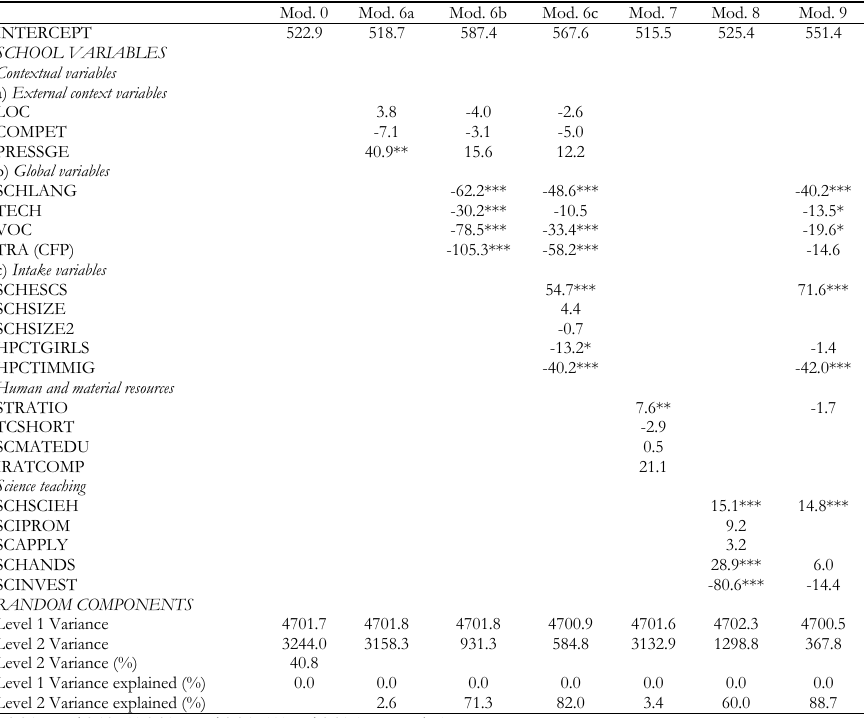
Net effects of level 2 variables on science